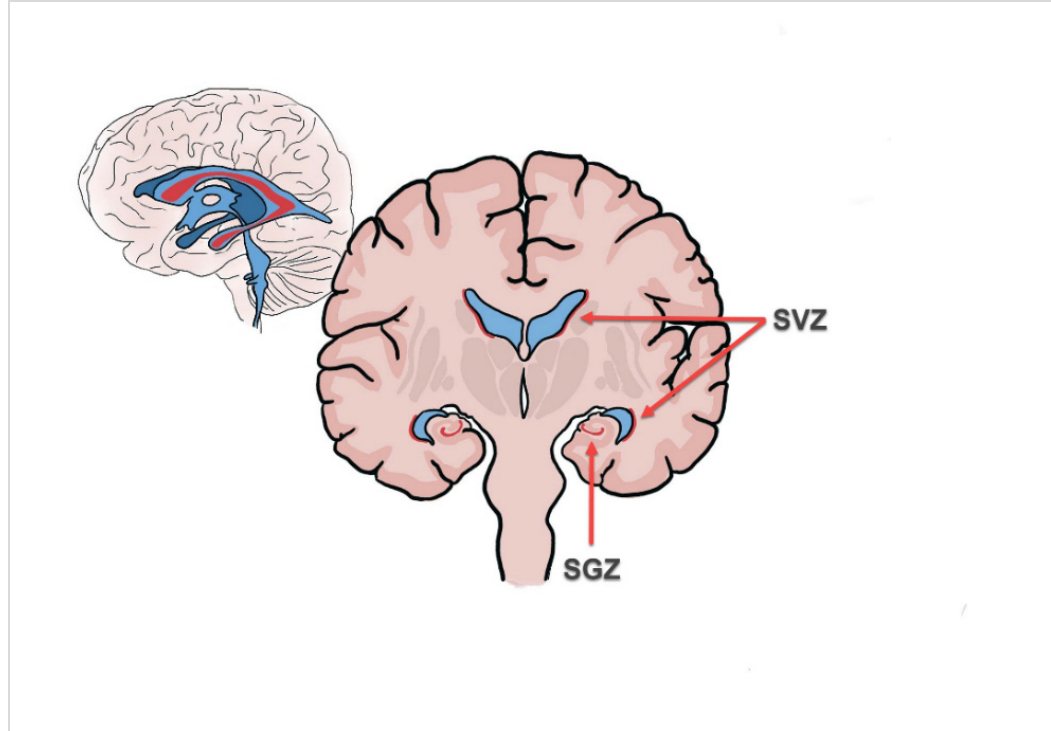
Figure 1. Illustration of the two main adult neurogenic niches, the subventricular zone (SVZ) of the lateral ventricle and the hippocampal dentate gyrus (subgranular zone;